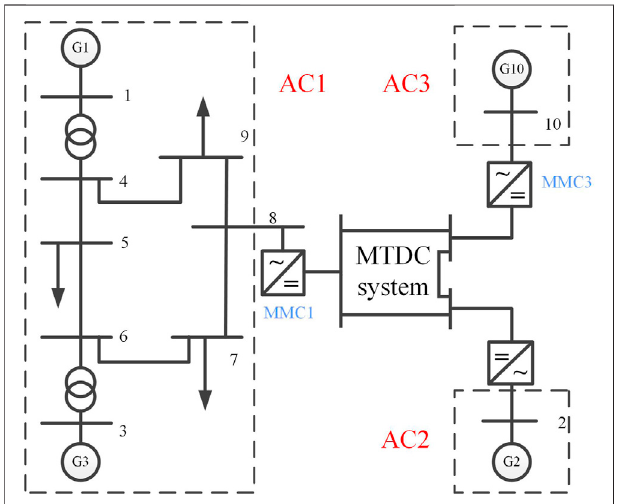
FIGURE 8 | Framework of the MMC – MTDC test